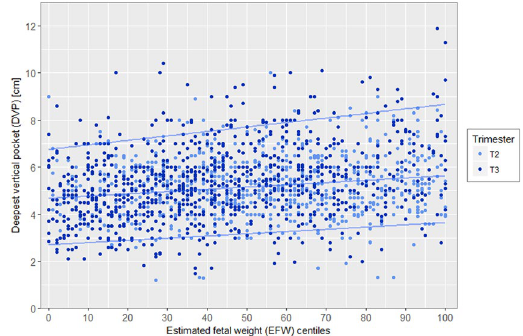
Figure 5. Distribution of deepest vertical pocket (DVP) according to estimated fetal weight (EFW) in centiles and stratified by 2nd (18–28 weeks) and 3rd (29–40 weeks) trimester of pregnancy.